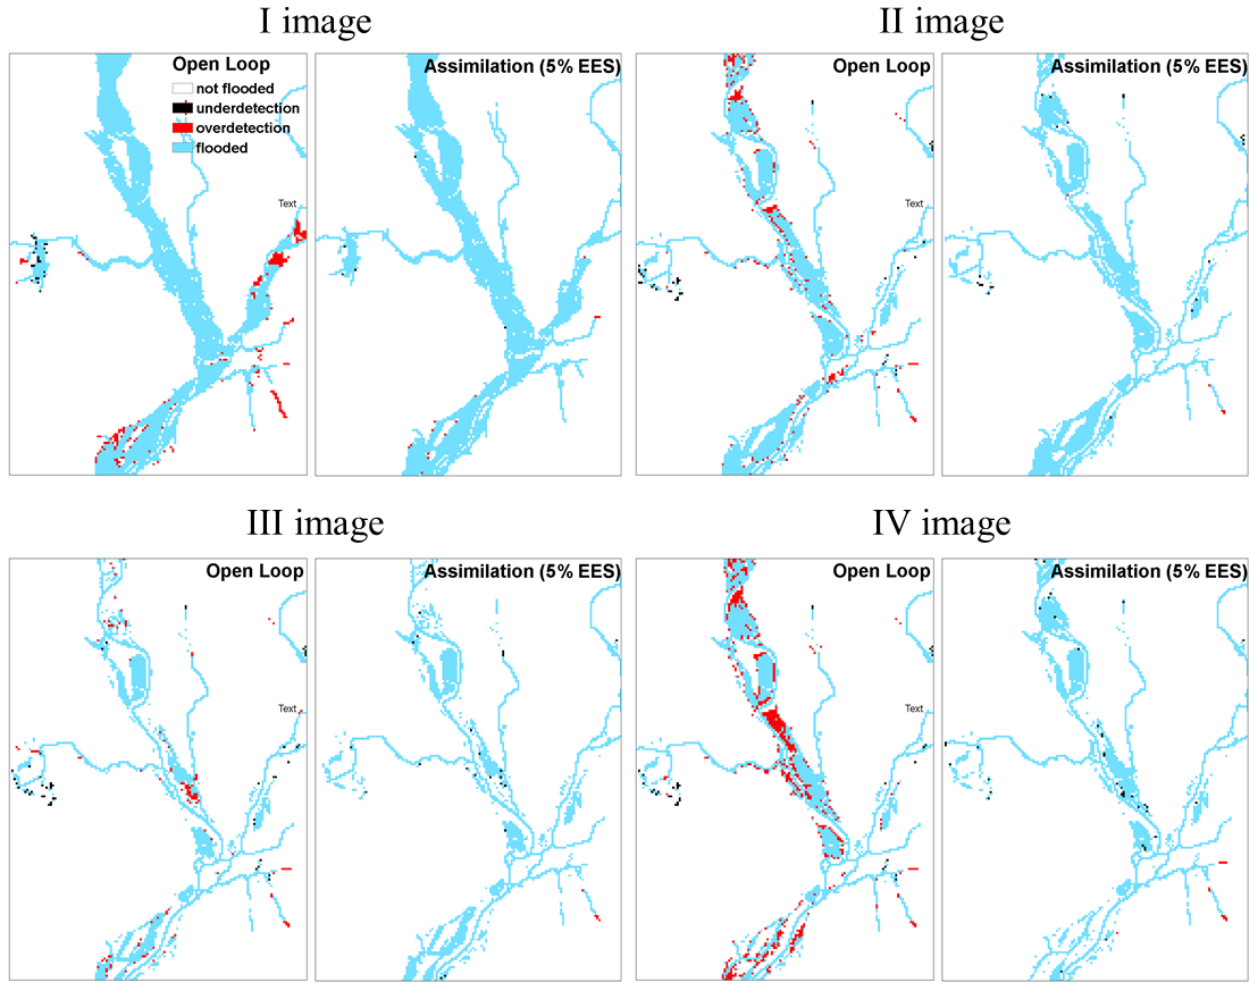
Figure 7. Contingency maps before (open loop) and after assimilation at 5% EES at each time step. Two types of errors can be distinguished: overdetection (red pixels) when the model predicts the pixel as flooded but the pixel is observed as non-flooded and underdetection (black pixels) when the contrary occurs. When the model and observations agree, pixels are correctly classified as non-flooded (white pixels) and flooded (blue pixels). Table 3. Root mean square error (RMSE [m]) at each assimilation time step. The open loop (Fig. 6) where no assimilation is computed is compared with the standard method and the adapted method with an increasing effective ensemble size (EES). Assimilation Open Assimilation times loop